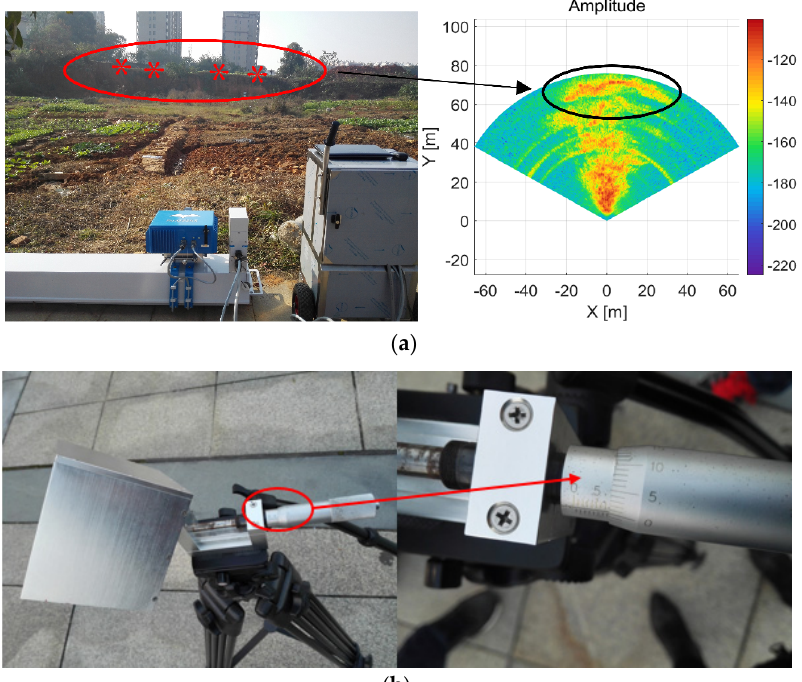
Figure 9. Electromagnetic wave reflection energy diagram experiment site of the small slope with adjustable CR. The picture on the left of part (a) shows the scene of the small earth wall slope monitoring. The positions of the four corner reflectors are marked in the figure, and the right picture shows the related electromagnetic reflection energy map. (b) is the adjustable corner reflector with